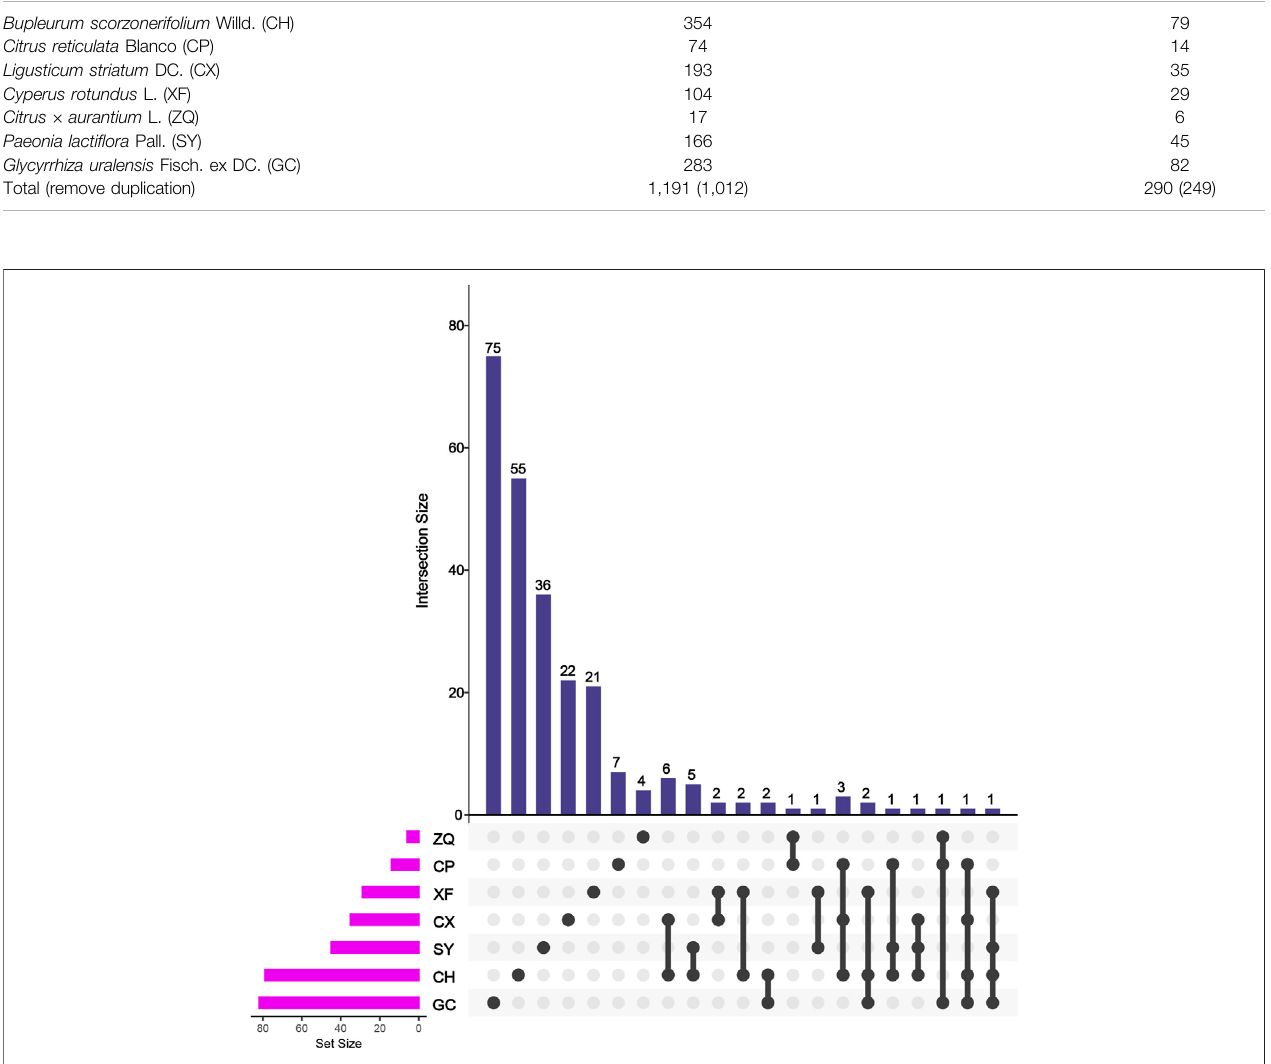
FIGURE 3 | Speci fi c and common components of botanical drugs in